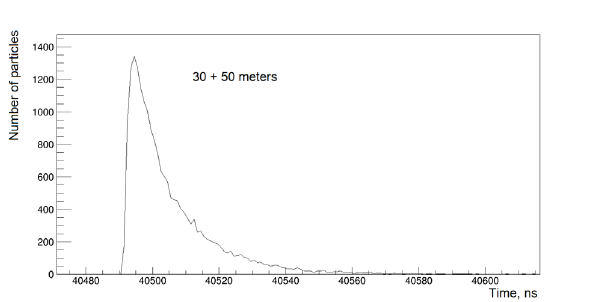
Figure 13. Two EAS disks side-by-side. Detector is 30 m from axis of one disk and 50 m from axis of another.